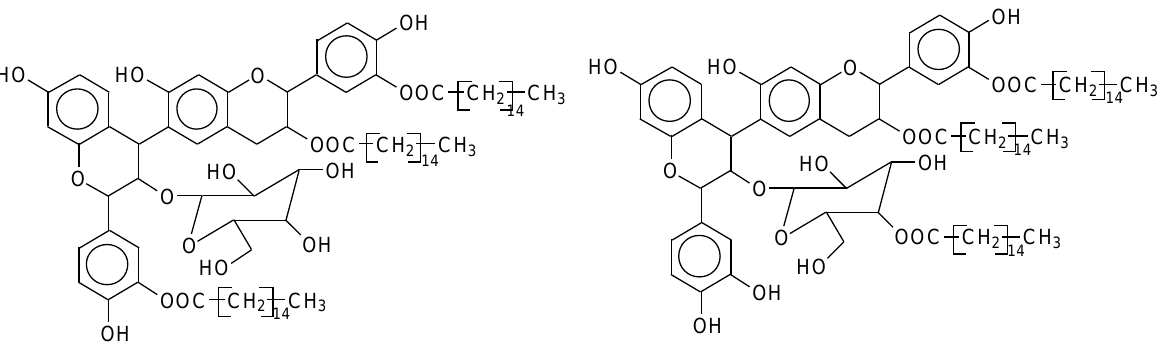
Figure 5. Example of the structures of two possible isomers of the identified species glucose- (fisetinidin) 2 -(palmitate) 3 at 1442 Da. Table 4. Characterization by MALDI-TOF of oil-grafted tannins using palmitoyl chloride.